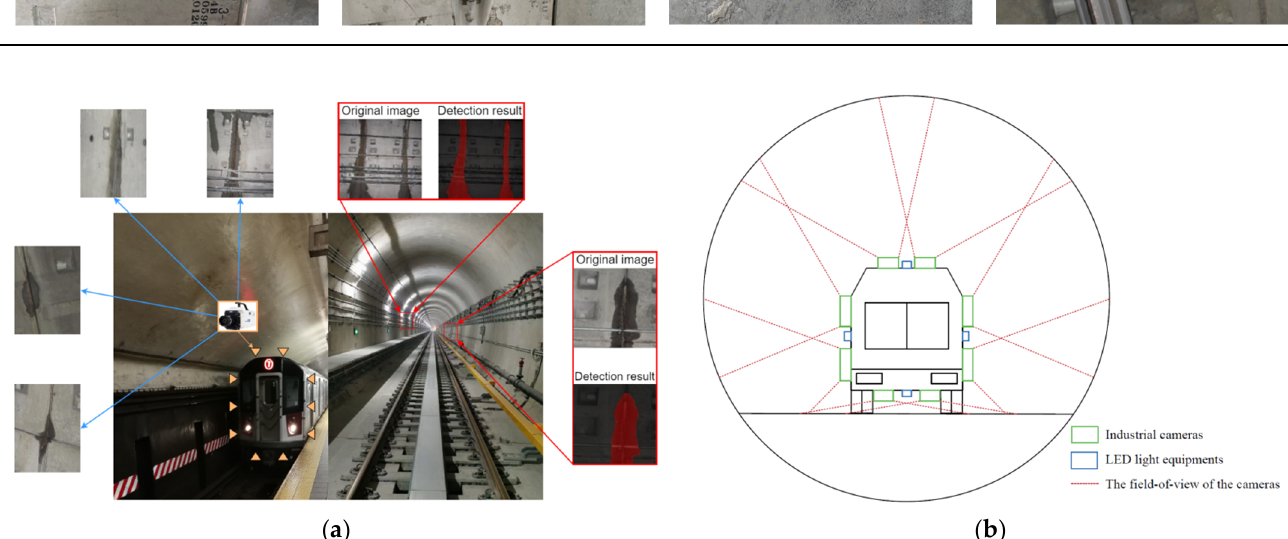
Figure 1. The Mobile Vision Measurement System. ( a ) The real-time detection, ( b ) The schematic diagram of the system